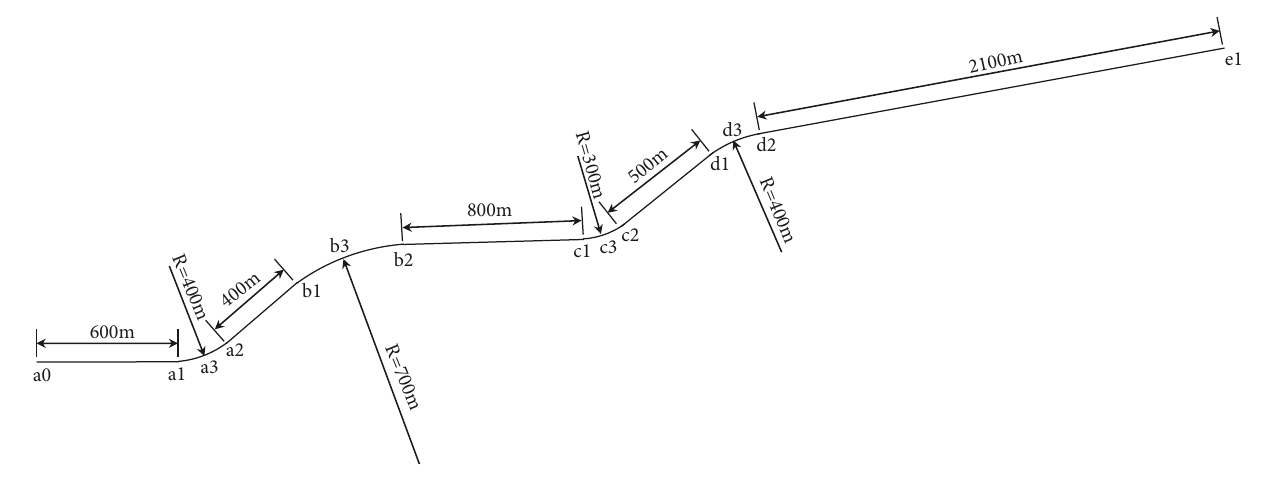
Figure 5: Experimental highway